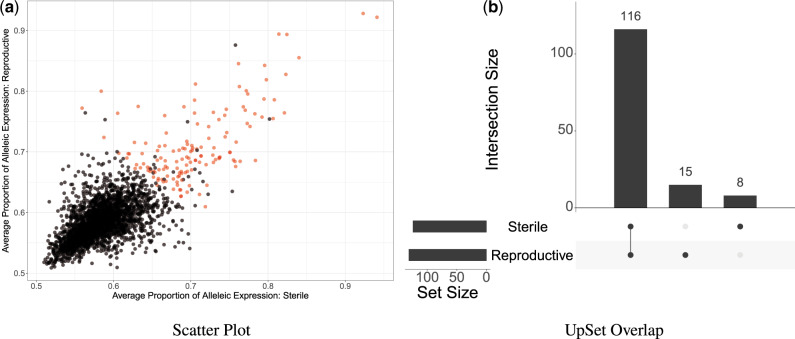
(a) Scatter plot showing the allele-specific expression proportion of sterile workers plotted against the allele-specific expression proportion of reproductive workers (the allele-specific expression proportion was averaged across colonies). Each point is a gene, the red points indicate genes showing significant allele-specific expression (q<0.05 and average allele-specific expression proportion >0.65). (b) An UpSet plot showing the number of genes with allele-specific expression shared by worker reproductive state and the number unique to reproductive or sterile workers (intersection size), indicated by a joint dot or single dot, respectively. The set size shows the total genes with allele-specific expression in either reproductive or sterile workers.